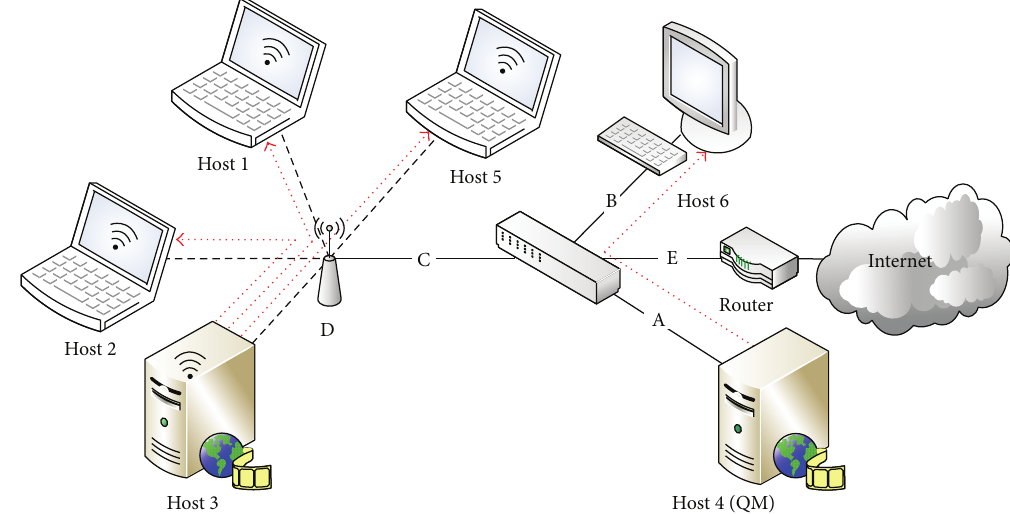
Figure 8: QoSiLAN evaluation